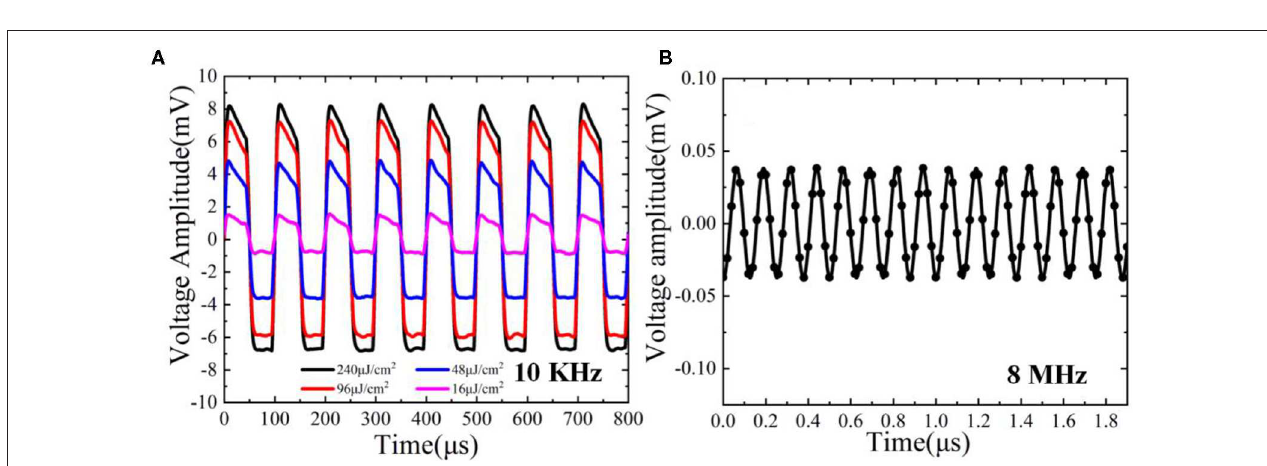
At switching speed of 8 MHz, the detected voltage amplitude falls to 0.05 mV. Figure 7A shows the terahertz transmission intensity distribution through the CsPbBr 3 -QD-embedded metasurface structure without pump laser fluence. The terahertz